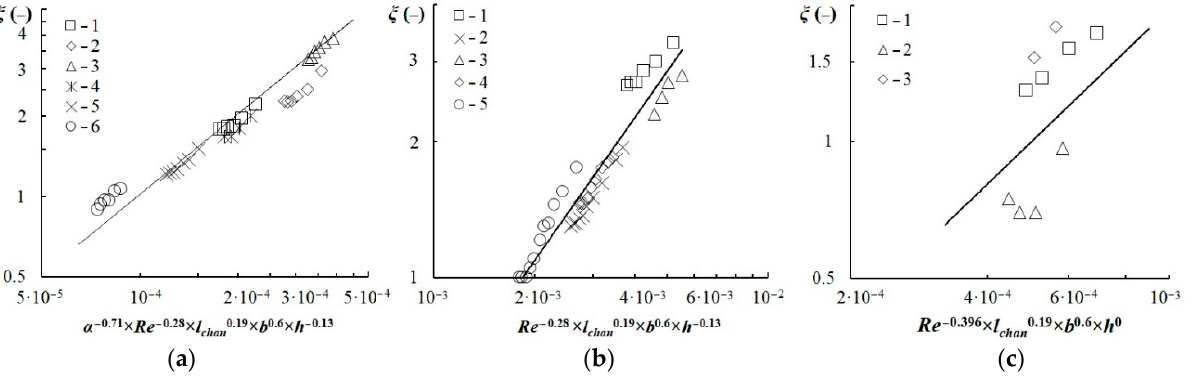
Figure 16. Dependence of the resistance coefficient ξ on 𝛼 (cid:2879)(cid:2868).(cid:2875)(cid:2869) ∙ 𝑅𝑒 (cid:2879)(cid:2923) ∙ 𝑙 (cid:3030)(cid:3035)(cid:3028)(cid:3041)(cid:2868).(cid:2869)(cid:2877) ∙ 𝑏 (cid:2868).(cid:2874) ∙ ℎ (cid:2879)(cid:2927) (right side of Equation (8)) for swirlers with straight parallel ( a ), profiled ( b ), and annular channels ( c ). Experimental points (according to Table 1): ( a ) 1—No. 2 at l w = 0.004 (m); 2—No. 5 at l w = 0.012 (m). 3—No. 6 at l w = 0.022 (m); 4—No. 7; 5—No. 10; 6—No. 11; ( b ) (1–5): 1—No. 12; 2—No. 13; 3—No. 14; 4—No. 15; 5—No. 16; ( c ) 1—No. 17 at l chan = 0.022 (m); 2—No. 18 at l chan = 0.022 (m); 3—No. 19 at l chan = 0.020